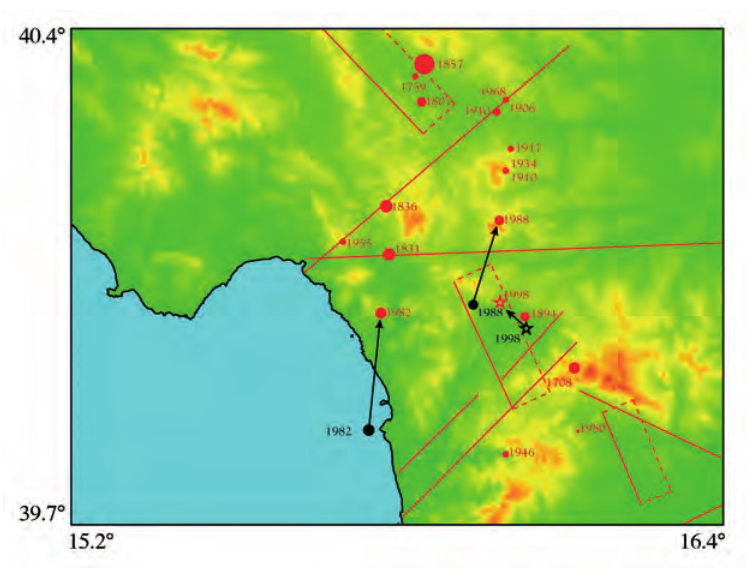
Fig. 2. Historical seismicity (red circles, radius increasing with macroseisimic intensity), main tectonic linea- ments (solid red lines), reported active faults on the base of geological evidence (dashed red rectangles – inter- section with the surface, solid red). Black circles show instrumental locations of the 1982 and 1988 seismic events and their relative dislocation with respect to the macroseismic epicentres. The star refers to the 1998 main event (sources: Gruppo di Lavoro CPTI, 1999; Valensise and Pantosti,